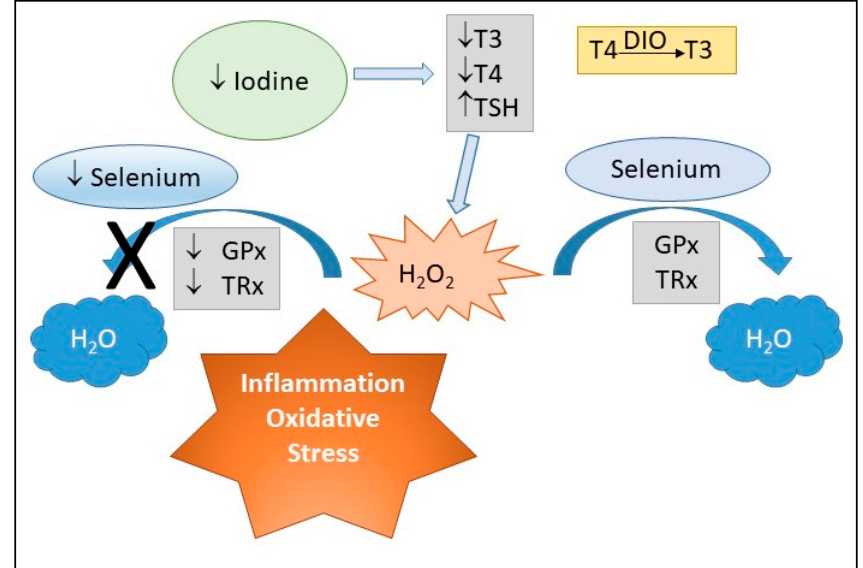
Figure 2. Deficiencies ( ↓ ) in iodine result in decreased ( ↓ ) T3 (triiodothyronine) and T4 (thyroxine) levels but increased ( ↑ ) TSH (thyroid-stimulating hormone) which results in more H 2 O 2 (hydrogen peroxide). Antioxidants such as GPx (glutathione peroxidase) and TRx (thioredoxin reductase) are selenoproteins and in the presence of adequate selenium can convert H 2 O 2 to H 2 O (water). However, if there is a selenium deficiency ( ↓ ), H 2 O 2 accumulates and can result in increased oxidative stress and